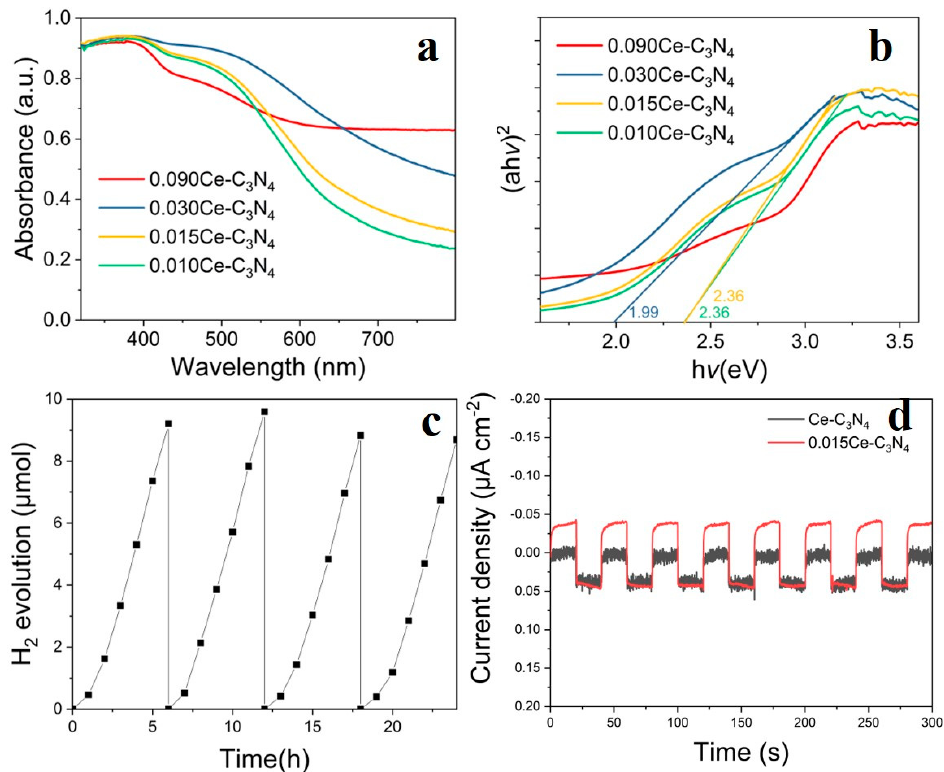
Figure 6. ( a ) UV-vis (Ultraviolet–visible spectroscopy) diffuse reflectance spectra of xCe-C 3 N 4 (x = 0.010, 0.015, 0.030, and 0.090). ( b ) Plots of ( α h υ ) 2 vs. photon energy (h υ ) of xCe-C 3 N 4 . (x = 0.010, 0.015, 0.030, and 0.090). ( c ) The 24 h cyclic measurement of H 2 evolution from 0.015Ce-C 3 N 4 . ( d ) Transient photocurrent response of Ce-C 3 N 4 and 0.015Ce-C 3 N 4 . The photocurrent responses of Ce-C 3 N 4 and 0.015Ce-C 3 N 4 are shown in Figure 6d. The